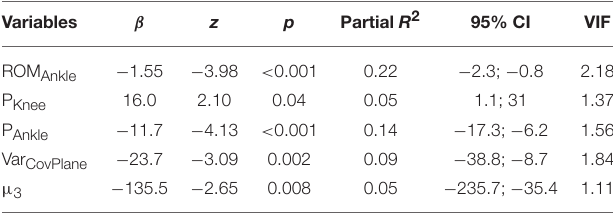
ROM Ankle , range of motion of the ankle in the sagittal plane; P Knee , maximal positive knee power; P Ankle , maximal positive knee power; µ 3 , foot-shank coordination; 95%CI, 95% confidence interval; VIF, variance inflation